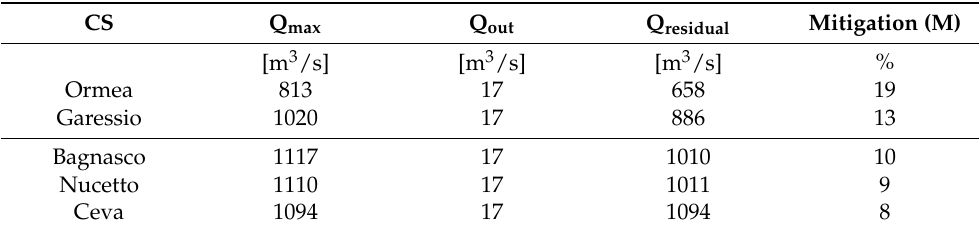
Table 8. The mitigation effect of the single Tanarello River dam as for its OS; the outgoing flow rate is equal to 17 m 3